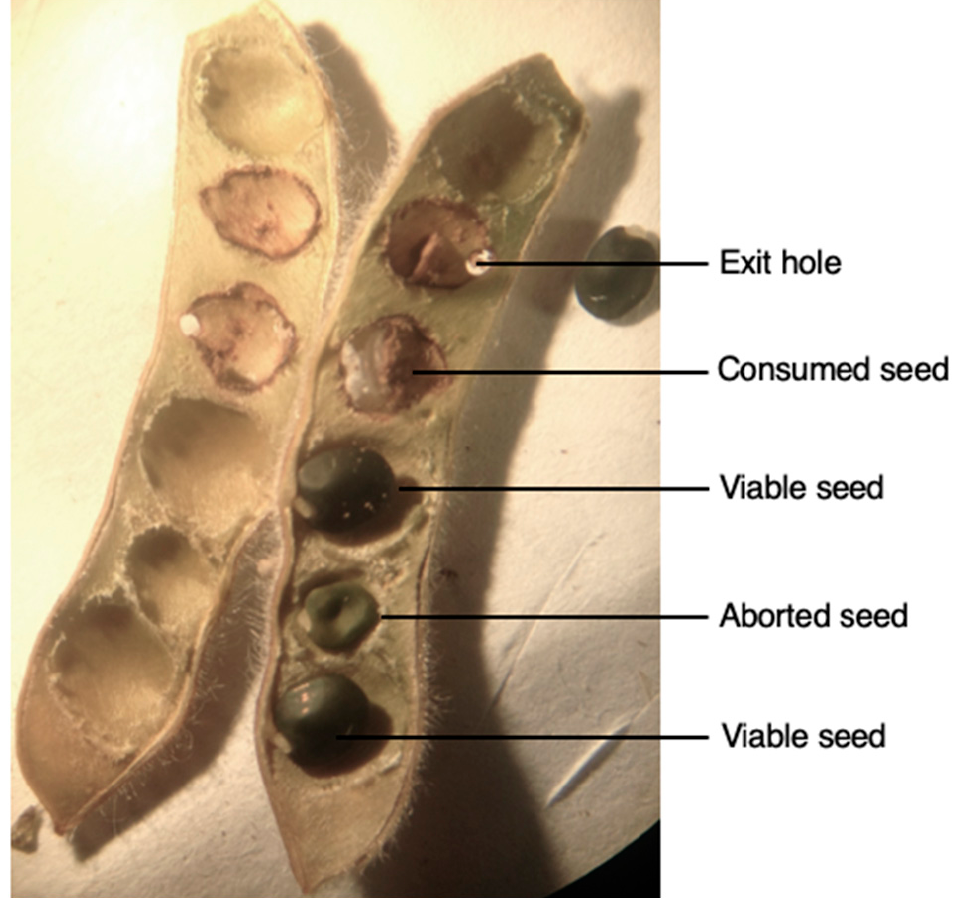
Figure 1. Infestation status of the three categories of pods of Genista monspessulana : pods with no exit hole and not infested by Lepidapion argentatum, pods with no exit hole but infested by L. argenta- tum (no adult emergence), and pods having at least one exit hole (adult emergence).